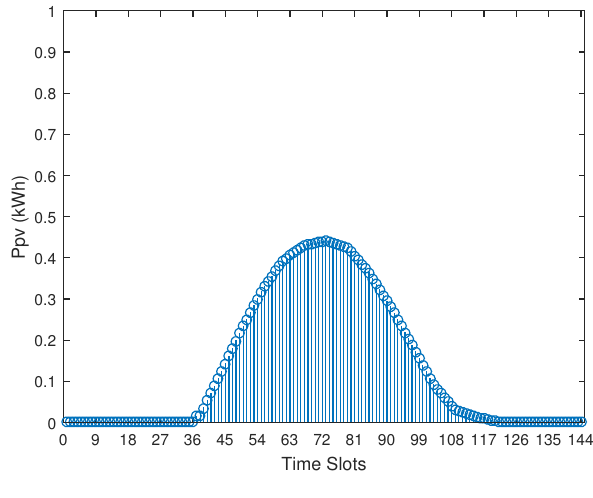
Figure 7. PV power